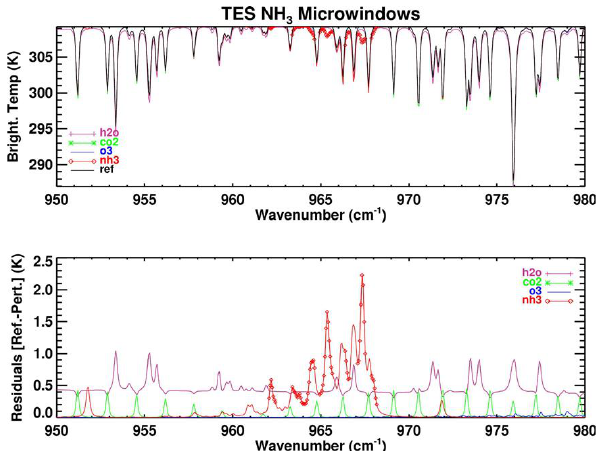
Fig. 1. Plot of the TES spectral microwindow selection for NH 3 retrievals. The top panel is the model (LBLRTM) simulated TES observation for a reference atmosphere (plotted in black). Overplot- ted in color are various simulated model calculations the reference atmospheric profile has been additionally perturbed separately by 10% H 2 O, 10% CO 2 , 10% O 3 , and the NH 3 increased to a pol- luted profile. The bottom panel shows the residual (reference – per- turbation) TOA brightness temperatures. The diamonds represent spectral points in the NH 3